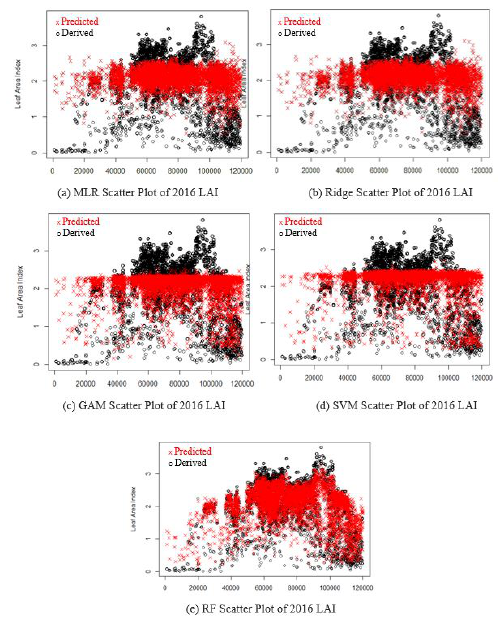
Figure 5. Derived and predicted LAI for each model in 2020.